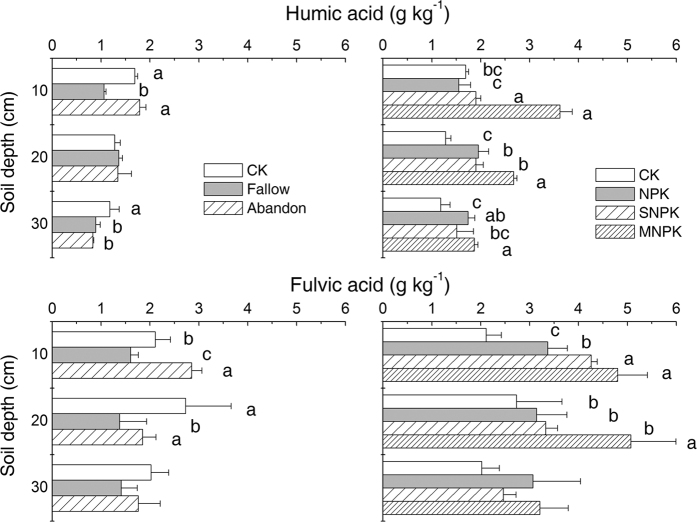
Humic (top panels) and fulvic (bottom panels) acid concentrations in bulk soils under contrasting soil management regimes (left panel) and fertilizer treatments (right panel).Error bars denote standard deviations (n = 3). Different small letters mean significant difference between treatments, at a given soil depth, at 0.05 (n = 3); no letters means no significant difference. Two-way ANOVA showed significant effects of soil management regime (P = 0.000) and soil depth (P = 0.000) and their interaction (P = 0.000) on humic acid content, and of fertilizer treatment (P = 0.000) and soil depth (P = 0.000) and their interaction (P = 0.000) on humic acid content. Two-way ANOVA showed significant effects of soil management regime (P = 0.001) and soil depth (P = 0.000) and their interaction (P = 0.004) on fulvic acid content, and significant effects of fertilizer treatment (P = 0.000) and soil depth (P = 0.001), but no marked interaction between them (P = 0.052), on fulvic acid content.